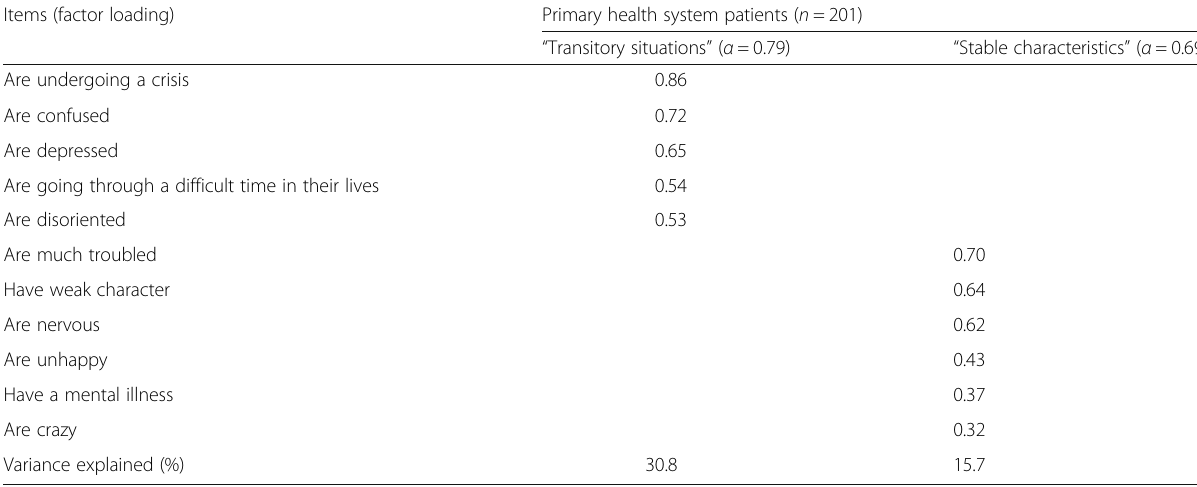
Table 3 Factorial structure of SBPP (EFA) — phase III Items (factor